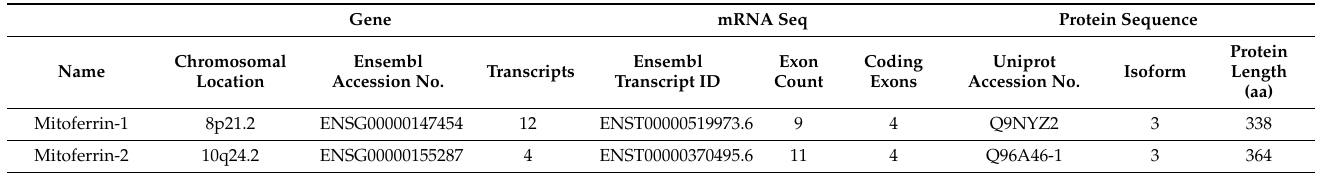
Table 1. Comparative chromosomal location, Ensembl accession number, transcript ID, exon count, uniprot accession number, and protein length of human mitoferrin-1 and